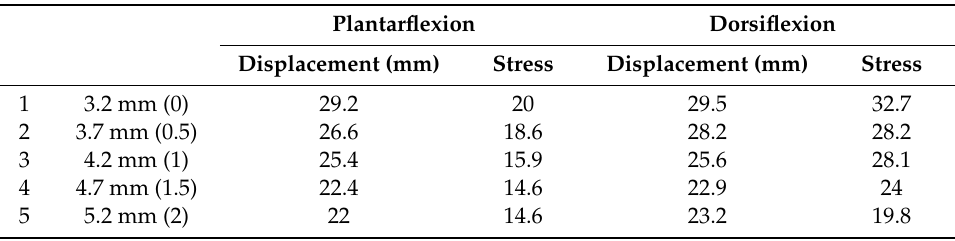
Table 1. Comparison of the maximum principal stress and the maximum displacement in different thicknesses of the 3DP-AAFOs at the neck.